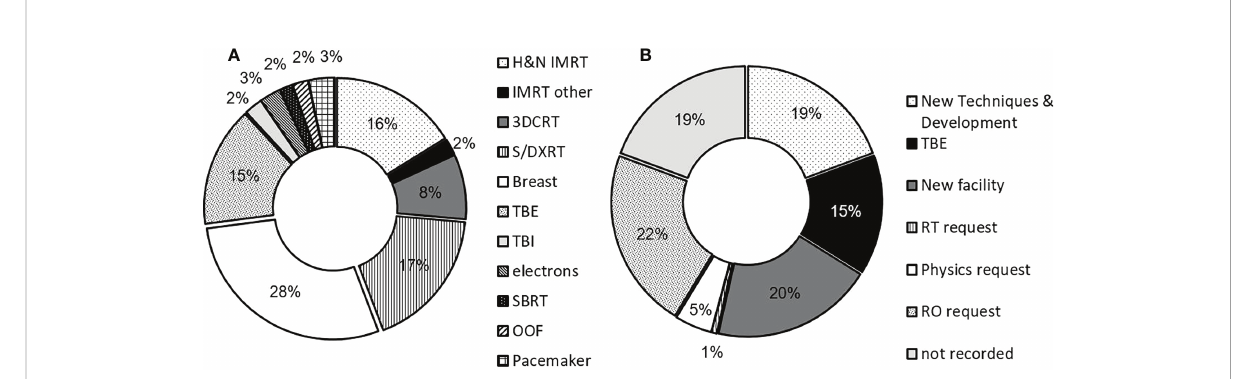
FIGURE 3 (A) Measurement applications for TLD service across all campuses and (B) distribution of TLD requests. Of the records where request data was available, radiation oncologists (ROs) were the highest instigator for TLD measurements, followed by opening of new radiotherapy facilities. Measurement applications include out-of- fi eld ( ‘ OOF ’ ), stereotactic ablative body radiotherapy ( ‘ SBRT ’ ), conventional electron treatments ( ‘ electron ’ ), total body irradiation ( ‘ TBI ’ ), total body skin electron ( ‘ TBE ’ ), 3D-conformal radiotherapy ( ‘ 3DCRT ’ ), breast, super fi cial and deep kilovoltage x-ray ( ‘ S/DXRT ’ ) treatments as well as IMRT. TBI is not routinely measured, and counts as a special